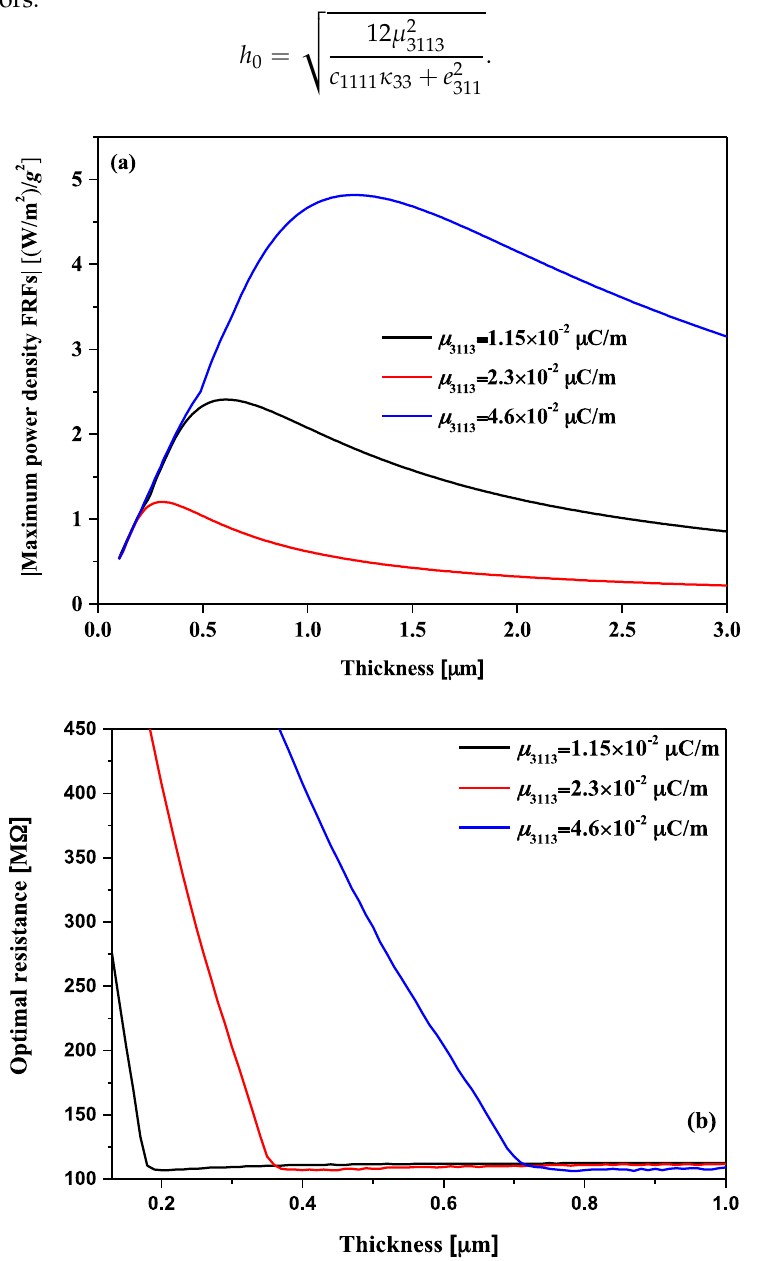
Figure 9. ( a ) Variation of the peak power density FRFs and ( b ) variation of the corresponding optimal Figure 9. (a) Variation of the peak power density FRFs and (b) variation of the corresponding optimal resistance with beam thicknesses at di ff erent flexoelectric coe ffi resistance with beam thicknesses at different flexoelectric coefficients.